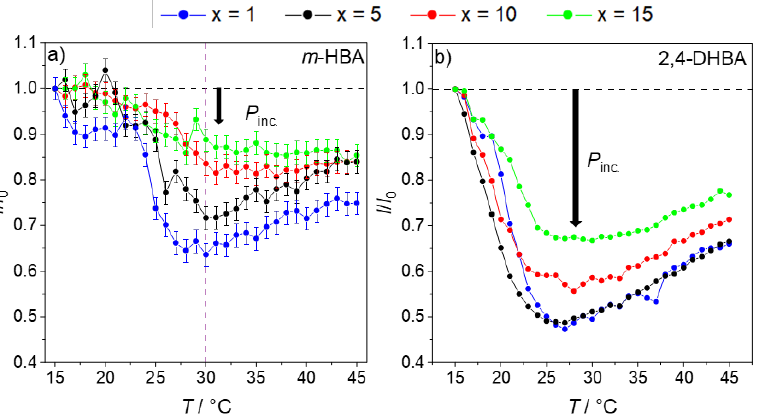
Figure 5. Integrated aldehyde proton signals from temperature dependent 1 H spectra (15 to 45 °C in 1 °C steps) for 20 mM of ( a ) m -HBA and ( b ) 2,4-DHBA in the presence of microgels using identical acquisition parameters. Integrals are normalized to the lowest temperature. The arrow indicates the maximum of P inc for 15% BIS.